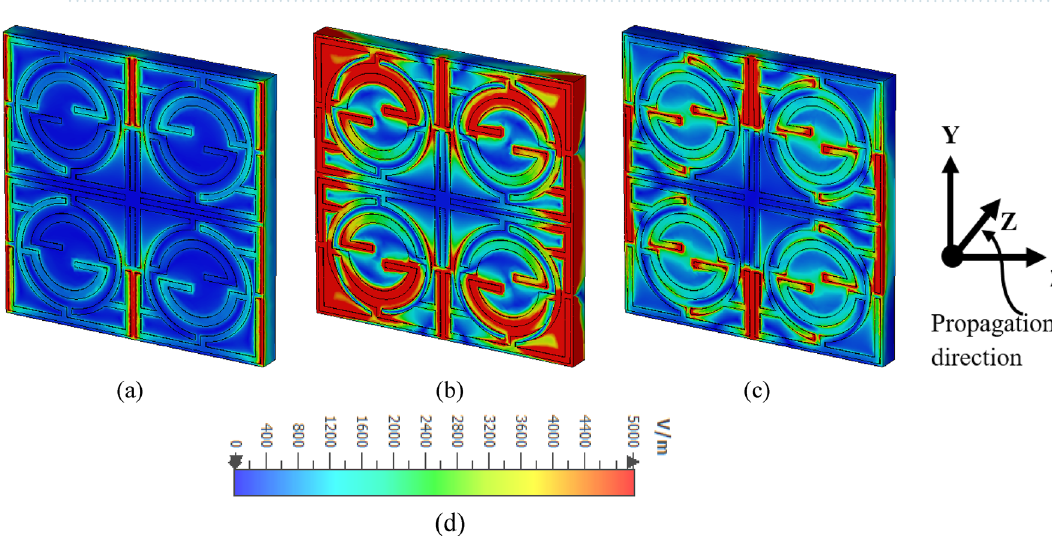
Figure 12. Electric (E) field distribution on MTM: ( a ) 1.98 GHz, ( b ) 4.74 GHz, ( c ) 8.34 GHz, ( d ) scale with color coded bar for the magnitude of the E field (CST microwave studio suite